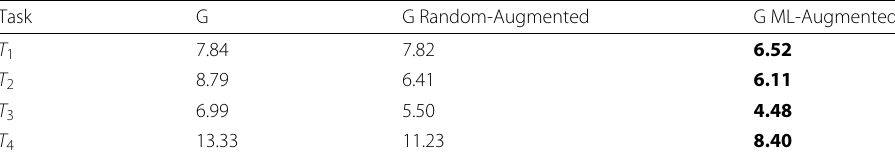
Table 1 Average Size of Teams for Task of size 10 — IBM Graph Task G G